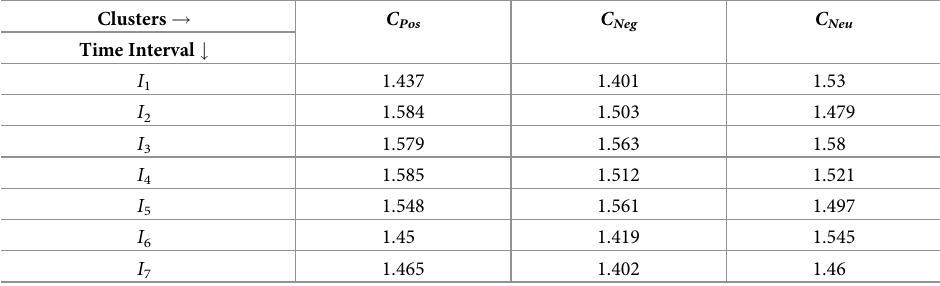
Table 8. Entropy of sentimental clusters at different I